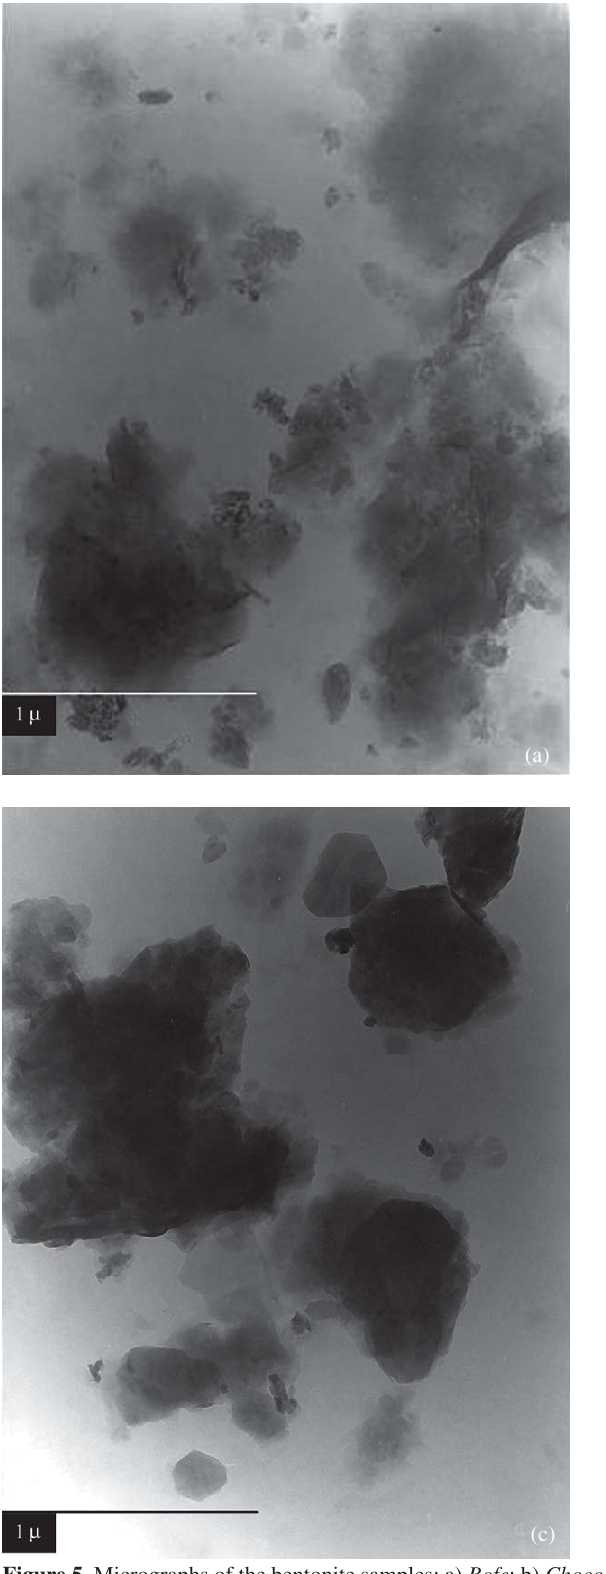
Figure 5. Micrographs of the bentonite samples: a) Bofe ; b) Chocolate ; c) Verde-lodo ; d) Dolomil ; e) Brasgel; f) Brasgel PA . Continue next